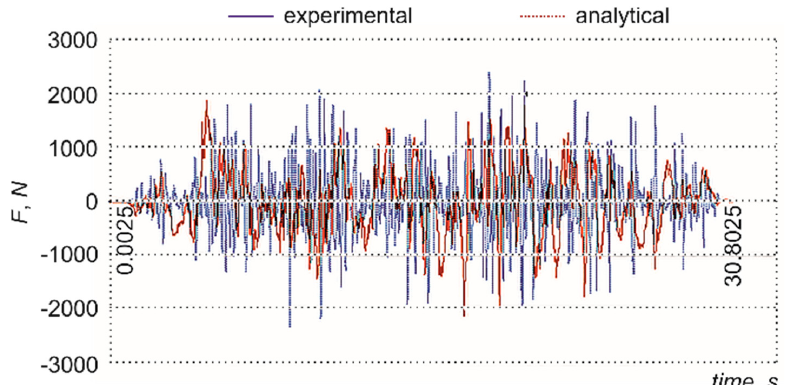
Figure 5. Experimental and analytical damping forces, F represents force.